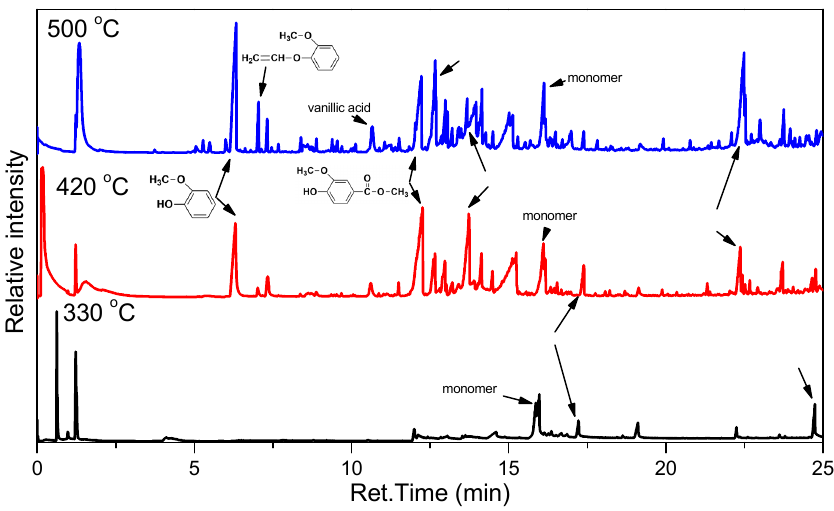
Figure 15. Total Ion Chromatographs of PEV after pyrolysis at 330 °C, 420 °C, and 500 °C. Table 2. Identified thermal degradation products of PEV after pyrolysis at different temperatures. The retention times of the larger peaks are denoted in bold.